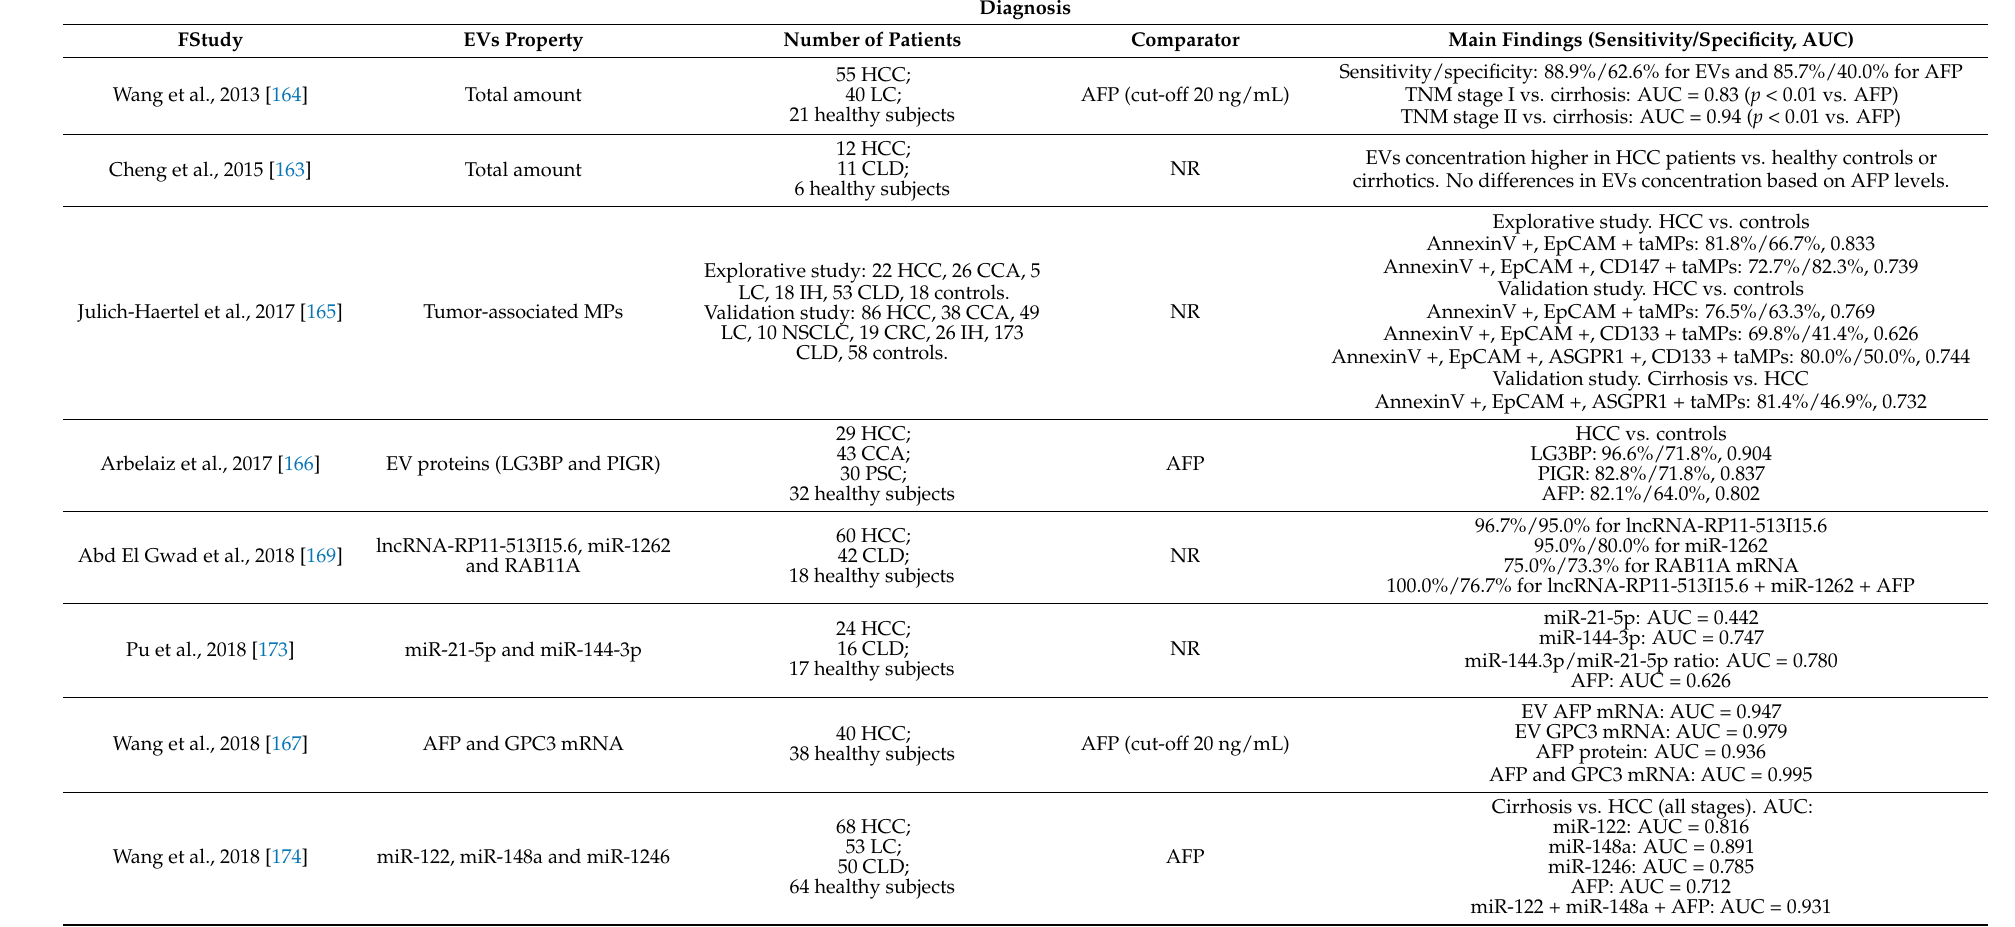
Table 2. Studies on extracellular vesicles (EVs) as biomarkers in HCC